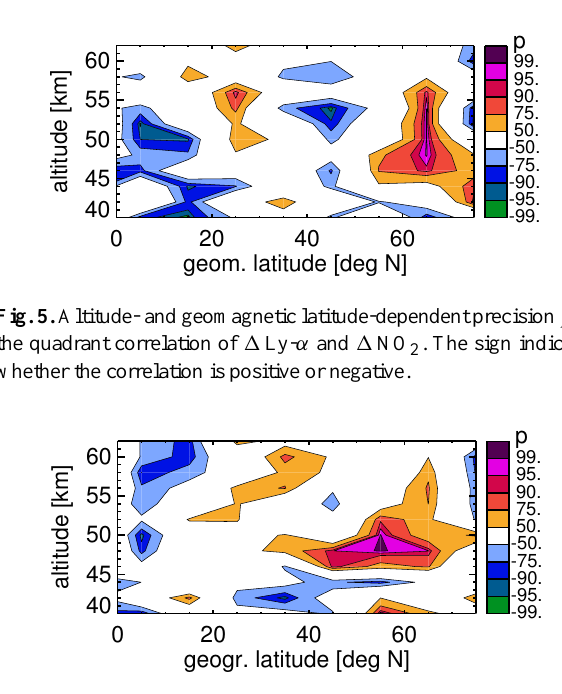
Fig. 6. Same as Fig. 5 but with geographic latitudes. Fig. 5. Altitude- and geomagnetic latitude-dependent precision p of the quadrant correlation of ∆ Ly- α and ∆NO 2 . The sign indicates whether the correlation is positive or negative.